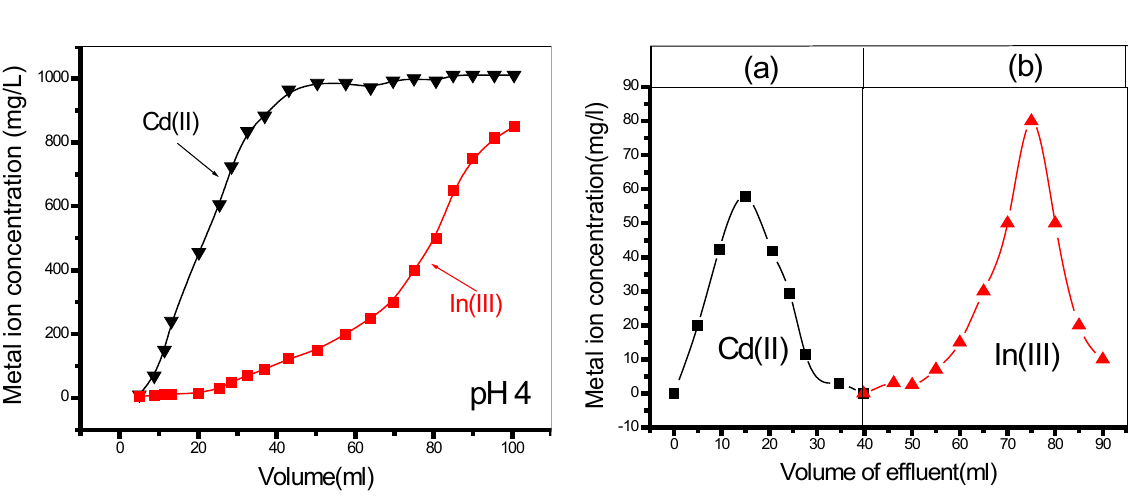
Figure 5. Elution curve of separation of In(III) and Cd(II) from Dowex 50w-x8 using (a) 0.05 M HCl and (b) 1 M HCl.